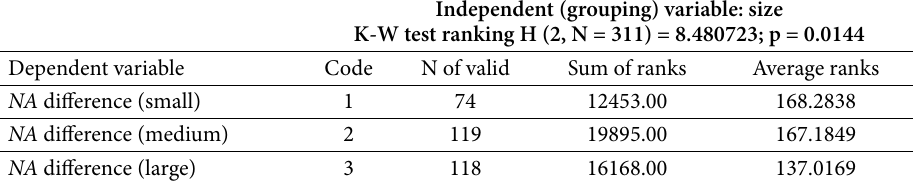
Table 6. Kruskal-Wallis test of NA difference based on ranks by size categories